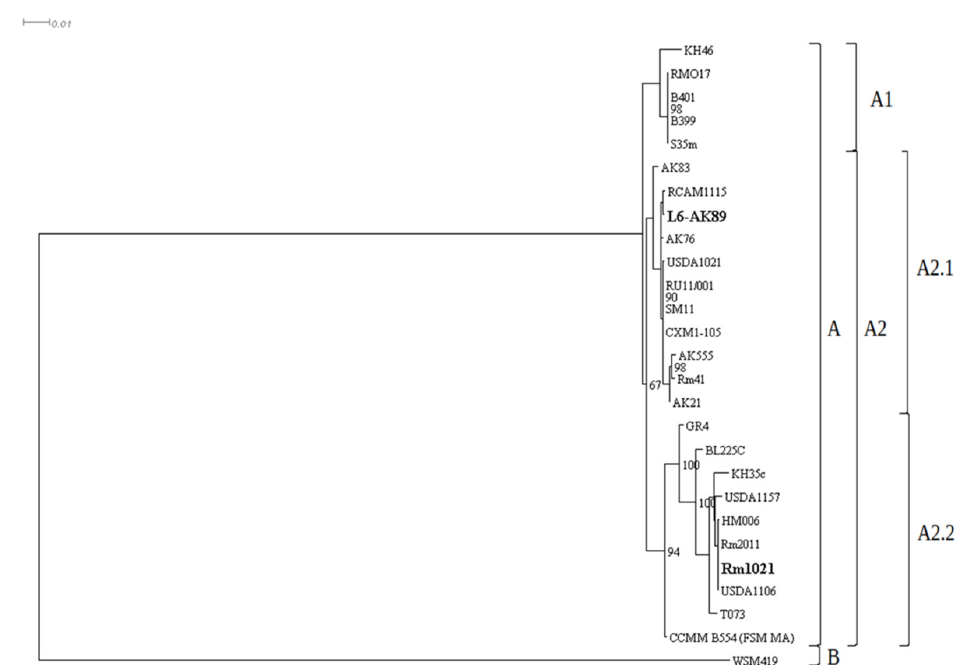
Figure 5. Phylogenetic analysis of concatenated nucleotide sequences of bet-kdp-ots A genes of Ensifer spp. Nucleotide substitution models selected for analysis were GTR + F + R5. Scale bar = 0.01 for concatenated bet / kdp / ots A nucleotide substitutions per site. Rooted tree was created by using maximum likelihood algorithm. Statistical support for internal nodes was determined by 1000 bootstrap replicates.